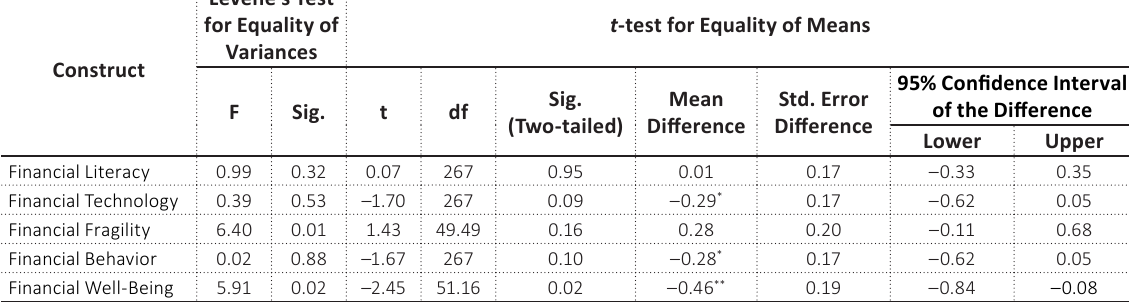
Table 11. Independent samples t -test on factors versus place of